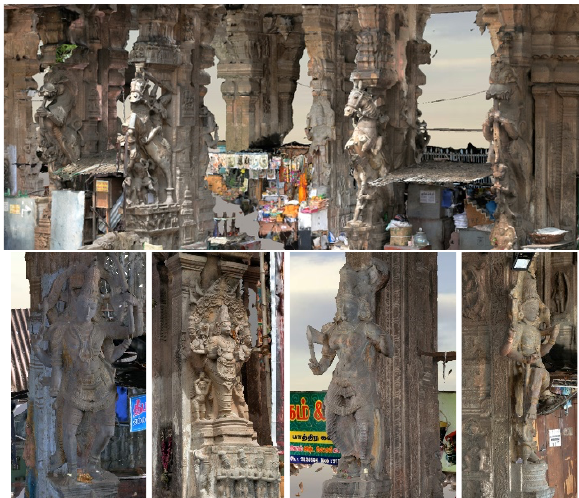
Figure 13. Mesh at the East end of the Pudhu Mandapam generated with © ContextCapture The success of the mesh creation from traditional photogrammetry at the East end was not, however, so straightforward in the highly contrasting internal areas. In addition literal movement of objects and people posed further challenges as can be identified in figure 14. Where multiple materials and changing positions of objects pose further challenges.